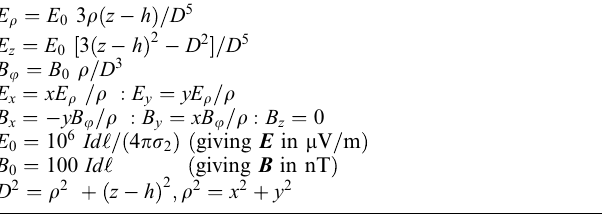
Table 4. Layer-2 primary fields of the VED